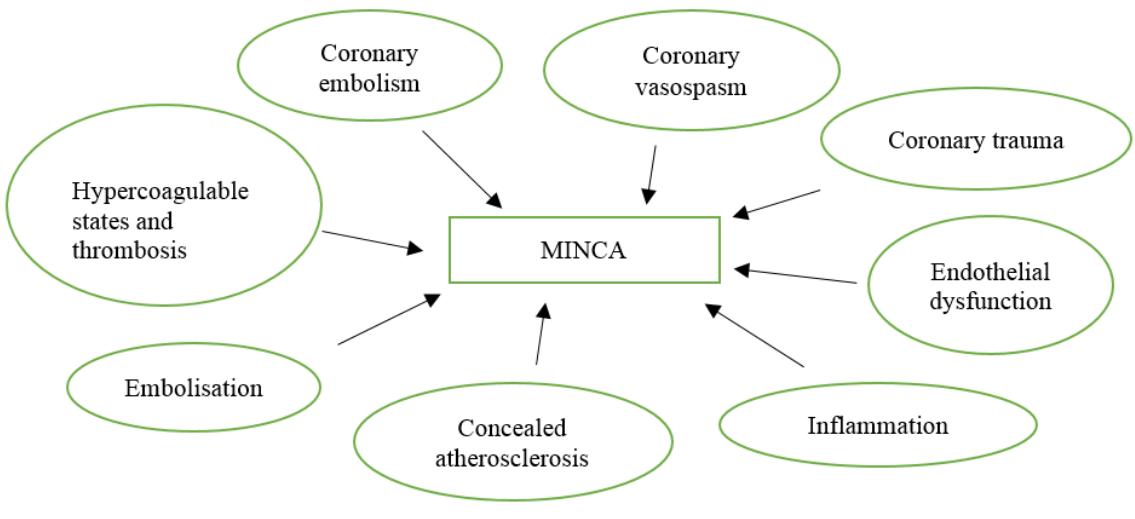
Figure 2: Probable pathogenic mechanisms of myocardial infarction with normal coronary arteries (MINCA).